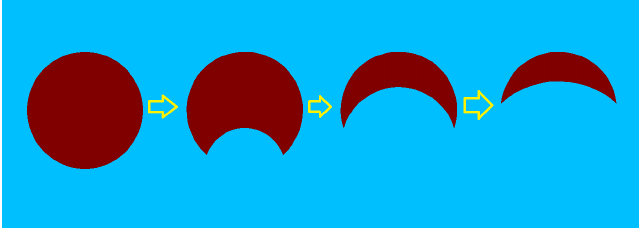
Figure 3. Arc-shaped stripe design evolution from a circular